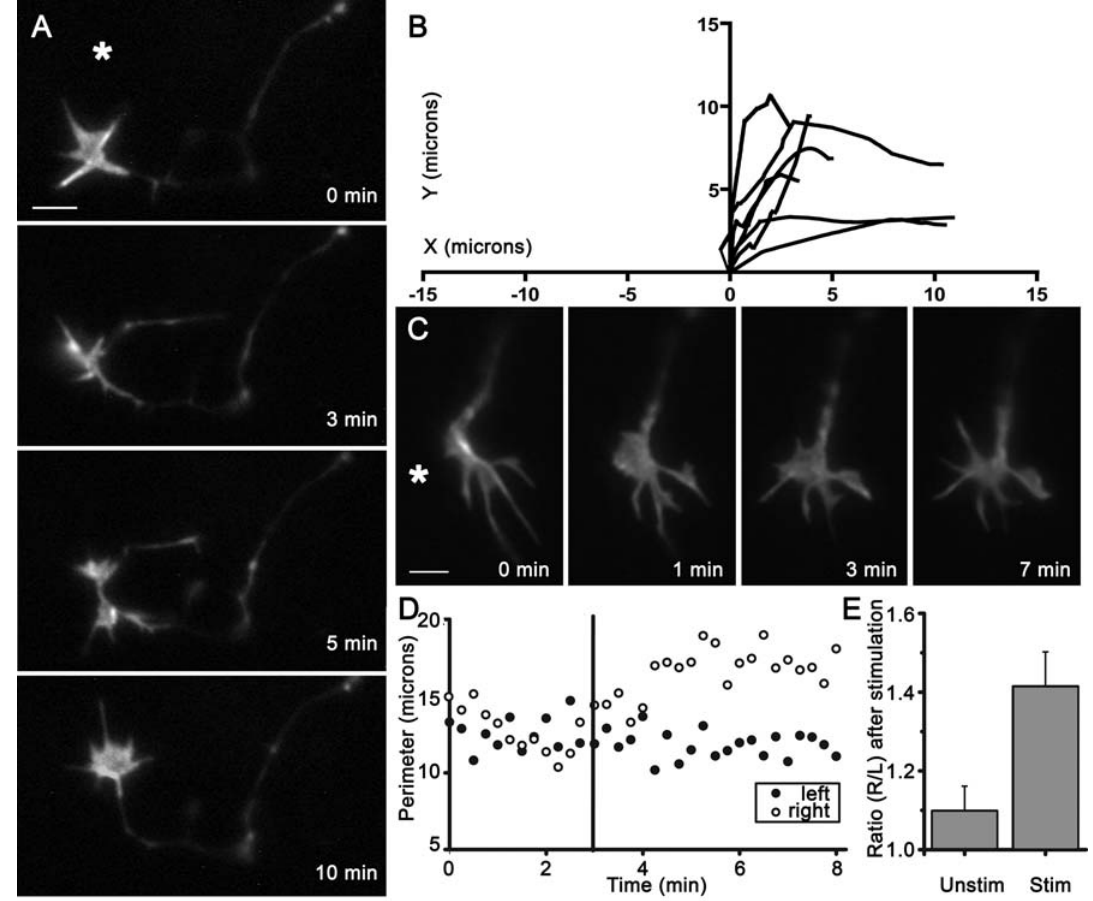
Figure 2. Activity induces attractive growth cone turning and filopodia sprouting. (a) An example of a growth cone that turned when the stimulation was repeated once every 5 minutes, as visualized by YFP-actin. (b) Superimposed traces of the trajectories of growth cones (n=5) that extended more than5 m m during longtermexperiments wherein neurons tothe right sideof the growth conewerestimulatedevery 5 minutesfor 0.5 to 1 hour. The origin shows the center of the growth cone at t=0, when its direction of growth was vertical. The axes show the distance in microns. (c) More filopodia protrude on the side of the growth cone that faces the area of stimulation, as visualized by YFP-actin. (d) A representative time series of the total perimeter of the left and right side of a growth cone during an experiment, measured from images taken 20 seconds apart. The vertical bar marks the first set of images taken after the stimulation. (e) The ratio of the total perimeter of the right side to that of the left (R/L) after a real stimulation is greater compared with that of a mock stimulation (unstimulated, n=25; stimulated, n=20). Bars show the mean, error bars are the SEM. Scale bars, 2 m